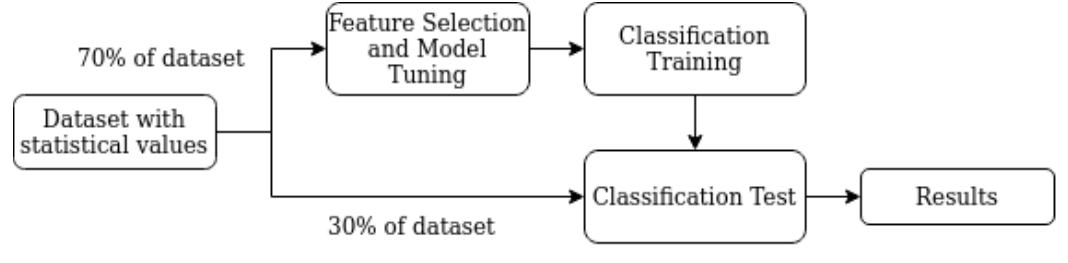
Figure 10. Classification Approach 1.